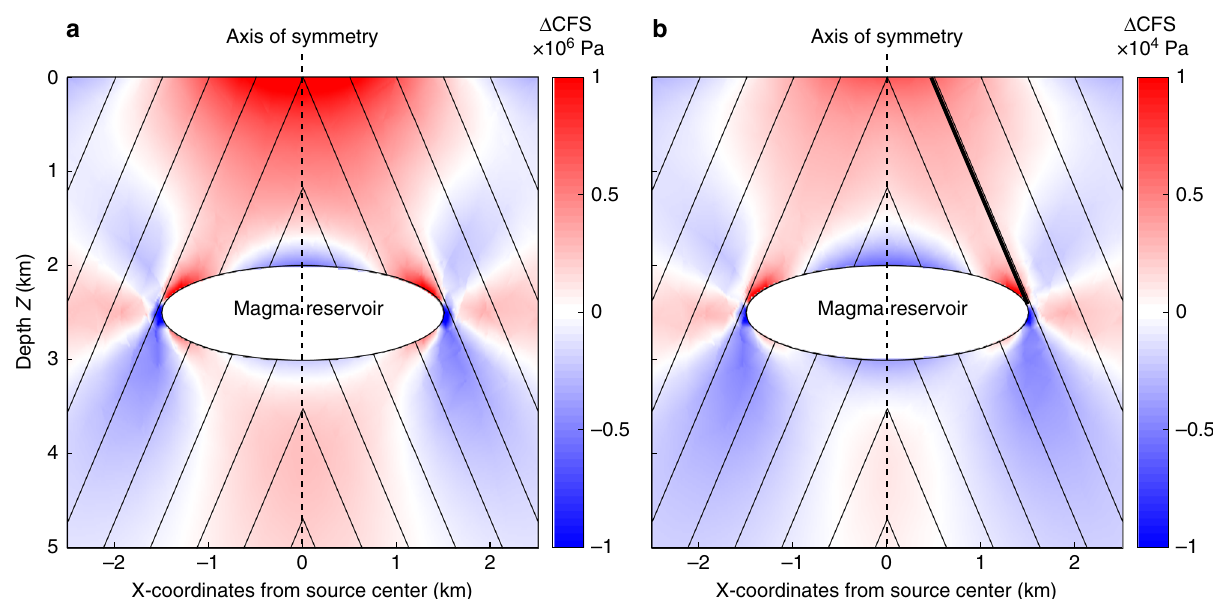
Fig. 3 Coulomb stress on normal faults above the magma chamber. Distribution of Coulomb stress changes on 67° dipping normal faults near the axial magma chamber. Positive values favor fault slip, negative values inhibit it. a For an overpressure of 1 MPa within the magma chamber with friction coef fi cient of the faults µ = 0.8. b For a decrease in vertical stress equivalent to a reduction in water level of 1 m. In b an effective friction µ ’ = 0.4 is used. The bulk modulus of the rock is assumed to be K r = 55 GPa, and the bulk modulus of the magma chamber is assumed to be K m = 1 GPa. The heavy line in Fig. 3b indicates the fault upon which Δ CFS was measured